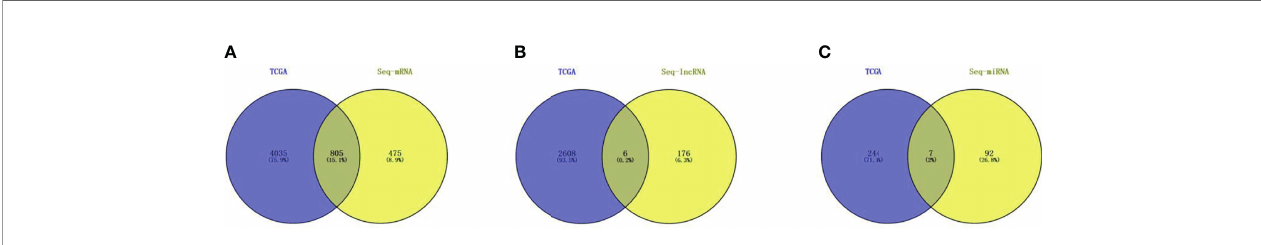
FIGURE 6 | TCGA HCC database and Seq differentially expressed RNAs co-expression analysis (A) Dif-mRNAs co-expression analysis; (B) Dif-lncRNAs co- expression; (C)